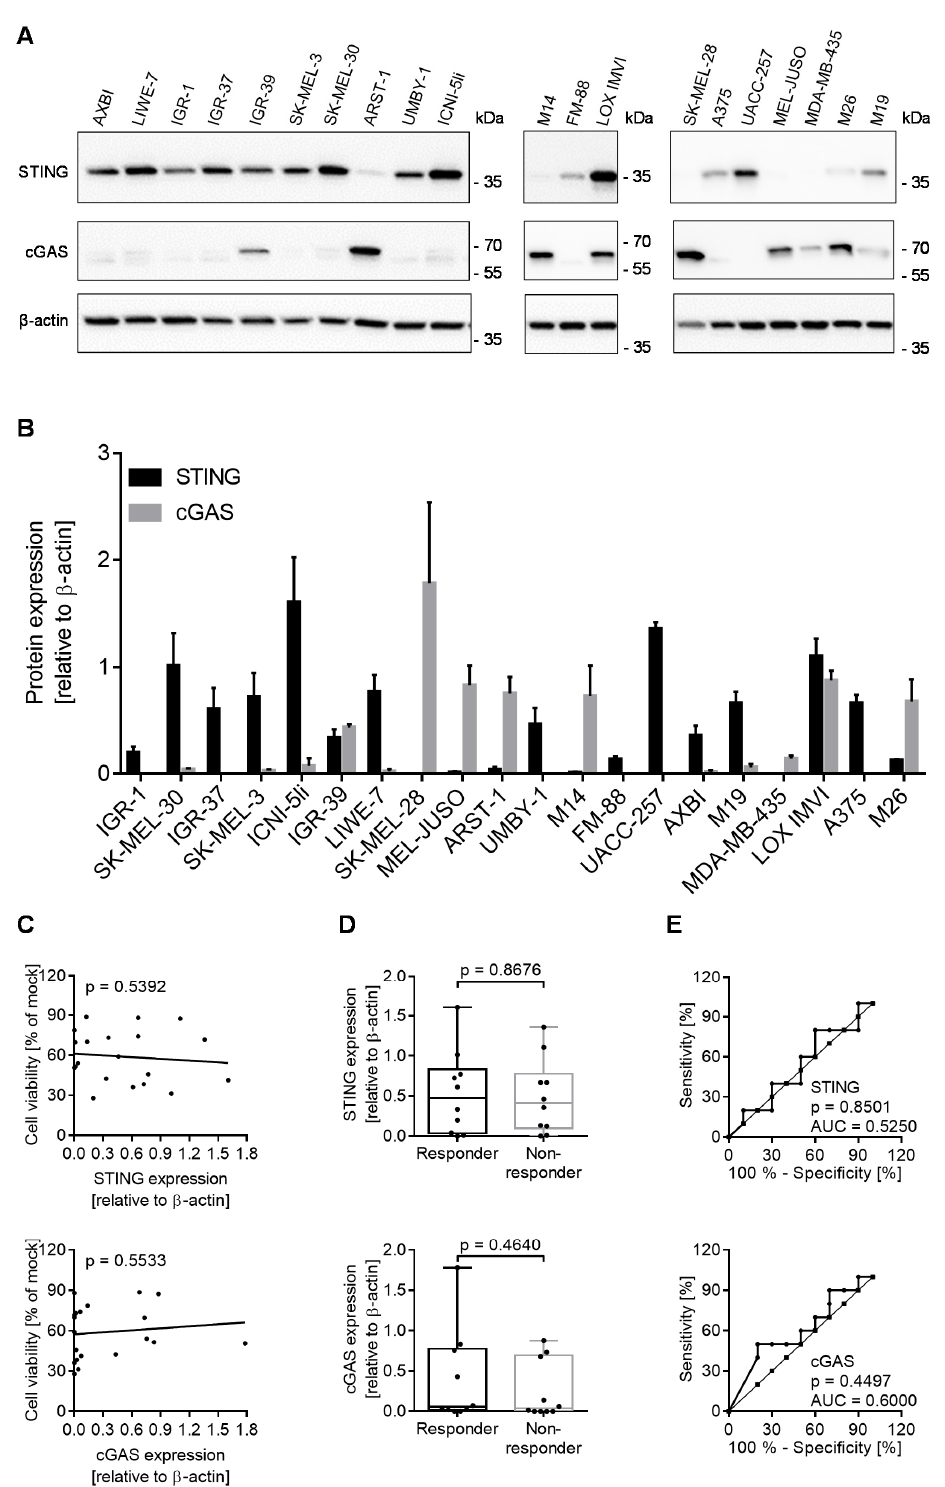
Figure 3. Correlation of the oncolytic activity of T-VEC with the expression of stimulator of interferon genes (STING) and cyclic GMP-AMP synthase (cGAS) in a panel of melanoma cell lines. ( A ) Western Blot analysis of STING and cGAS with respect to housekeeping protein ß-actin using lysates of 20 melanoma cell lines. ( B ) Densitometric quantification of STING and cGAS, normalized for ß-actin and shown as the mean and standard error of three independent Western blot experiments. ( C ) Spearman correlation coefficient, ( D ) box plot, and ( E ) ROC curve analyses of all responder and non-responder cell lines with respect to STING (upper part) and cGAS expression (lower part) and corresponding susceptibility to T-VEC induced cell death. p values for box plots were calculated using the Mann–Whitney test; ROC curves analyzed the area under the curve